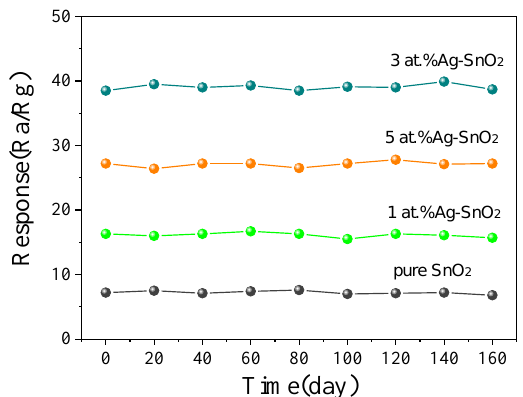
Figure 10. The long-term stability of pure, 1 at.%, 3 at.% and 5 at.% Ag-doped SnO 2 to 100 µL/L H 2 at their optimum temperatures.